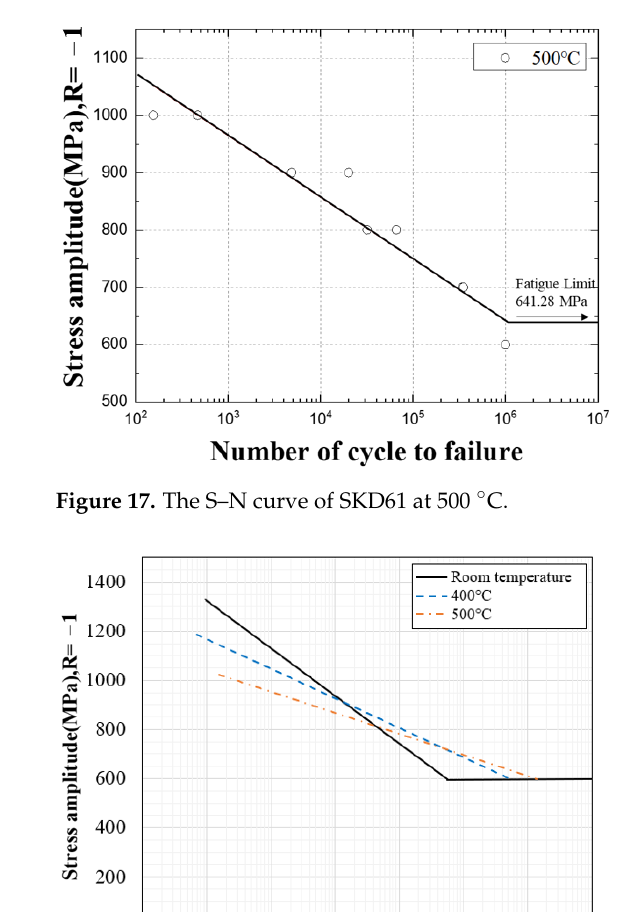
Figure 16. The S–N curve of SKD61 at 400 °C.